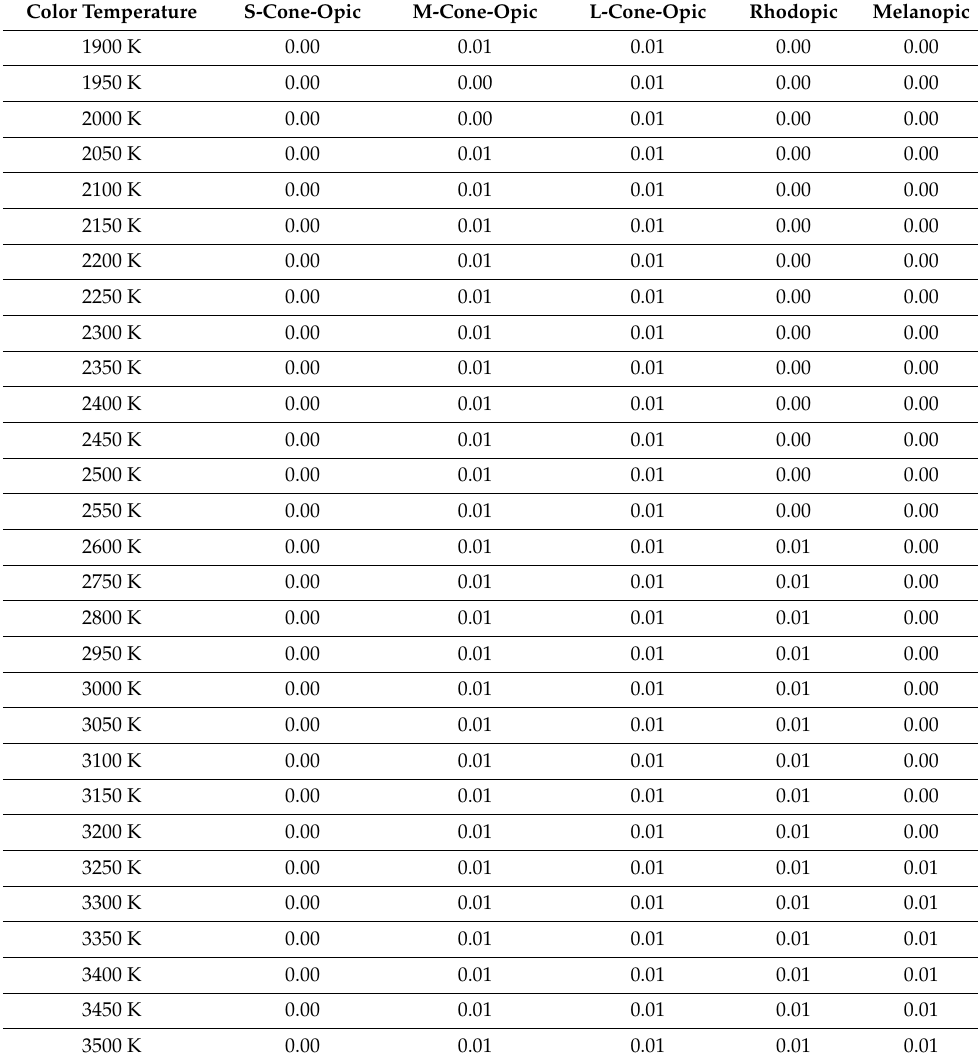
Color Temperature S-Cone-Opic M-Cone-Opic L-Cone-Opic